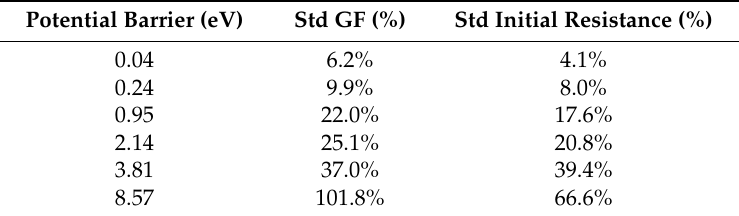
Table 1. Reproducibility of the GNP network as a function of the potential barrier.